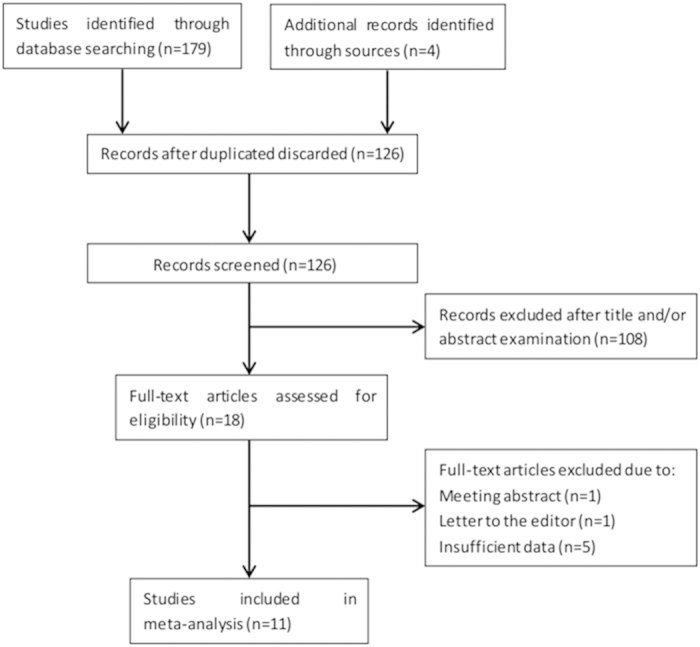
Flow chart of the study selection.